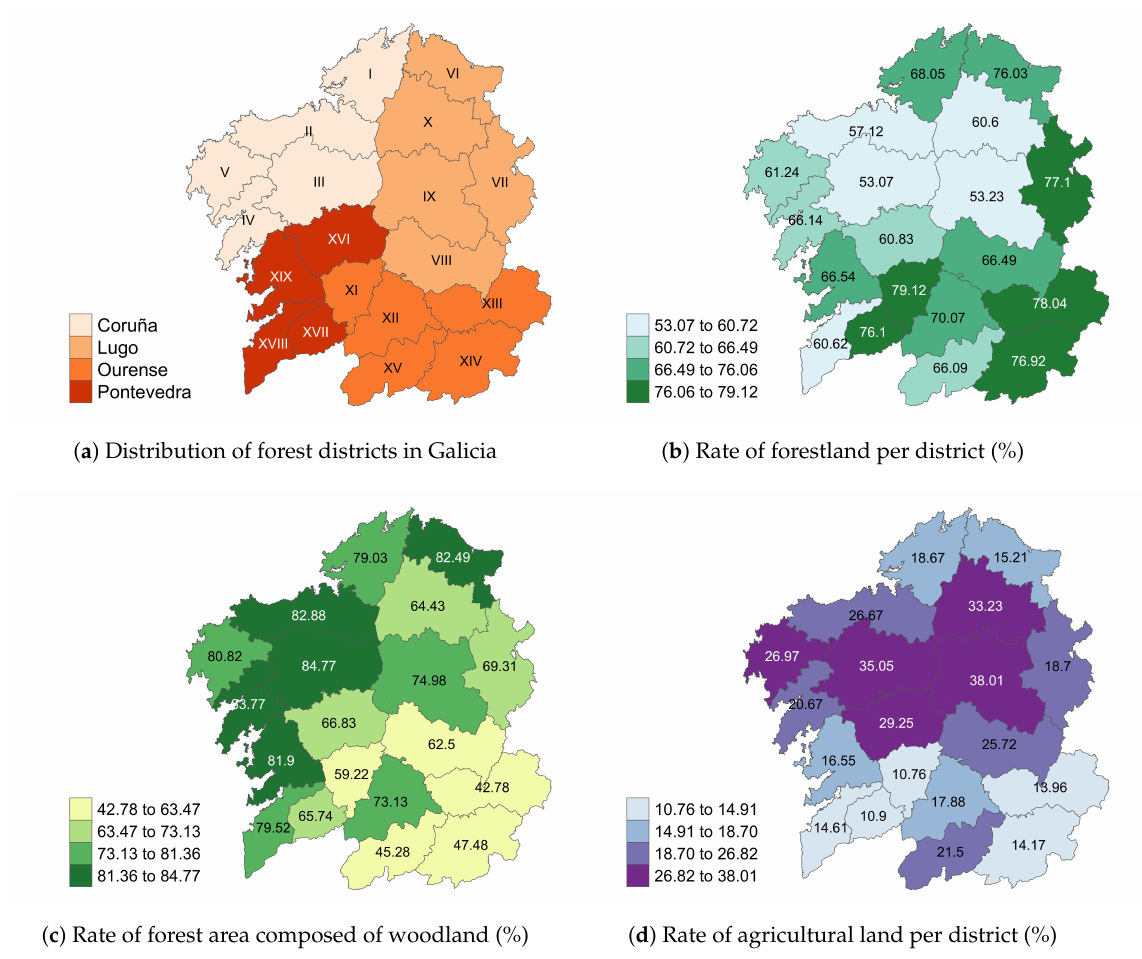
Figure 2. Galician Forest District description. Data obtained from Galician Statistical Office